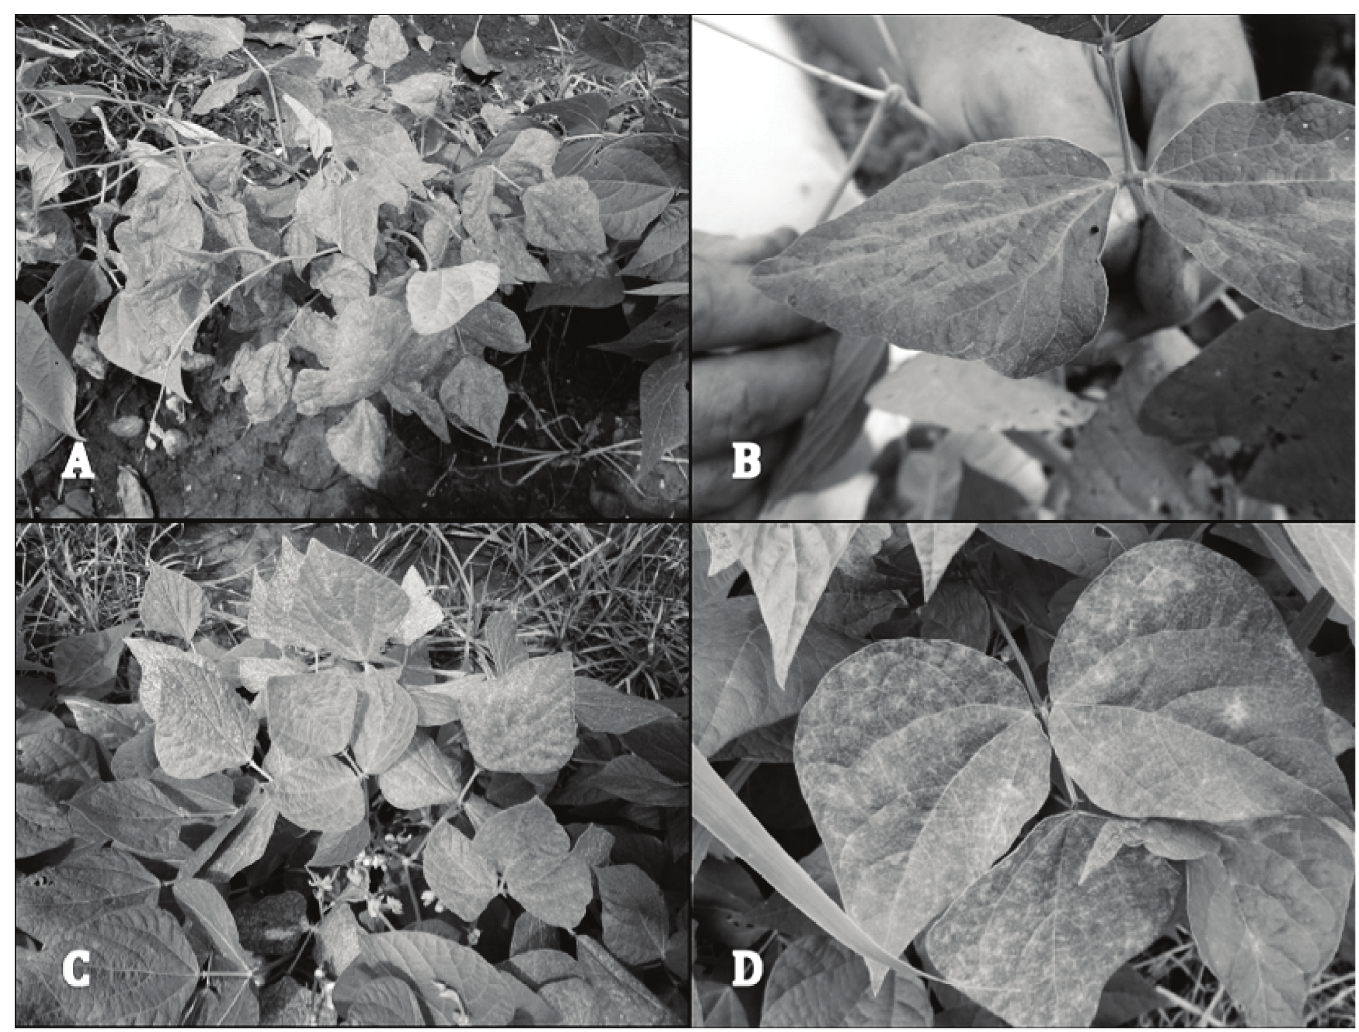
Fig 4. Symptoms observed in common bean plants in La Compa ñ ia, Nicaragua. (a), Stunting of the plant, malformation and blisteringof leaves. (b), Mild epinastyand vein reversion. (c), Green-yellow chlorosis.(d), Green-yellow mosaic.